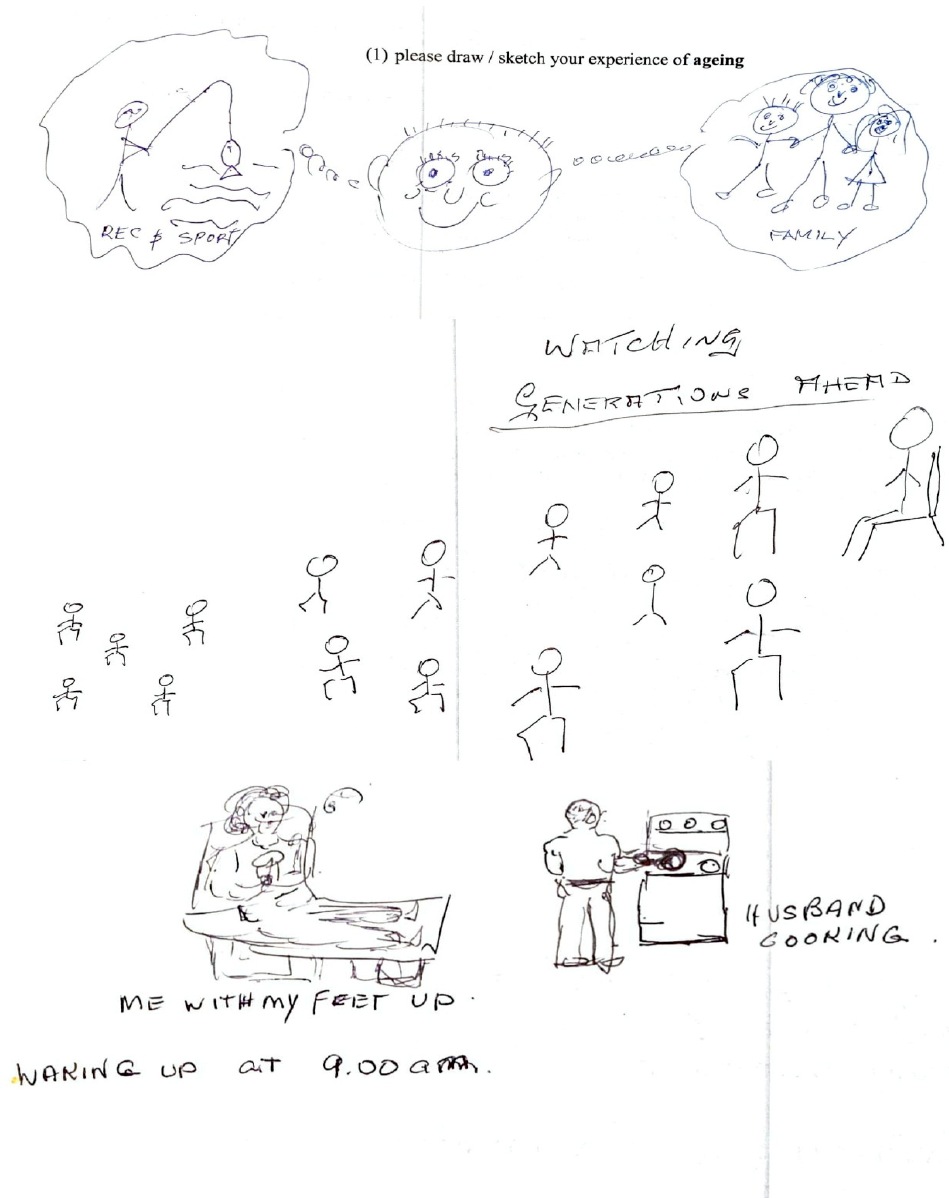
Figure 1. Enjoying family, creating moments and memories that matter. Jill’s experience of ageing was very similar, as we see in Figure 2. Naming her sketch “ Enjoying my 19 grandchildren ”, Jill’s sketch showed more fun, less drudgery, as she did less housework and purposefully created more time for the things she enjoyed in life: more time for reading, hobbies, and leisure activities (table-tennis, music), more time for enjoying her 19 grandchildren, and, simply, more time for “togetherness” with friends and family. Jill did not negate some of the negative health challenges of her ageing experience, drawing a picture of her ‘creaking joints’ which made getting out of bed each morning harder and her need for hearing aids—but her drawing focussed on the more positive moments and enjoying the gift of